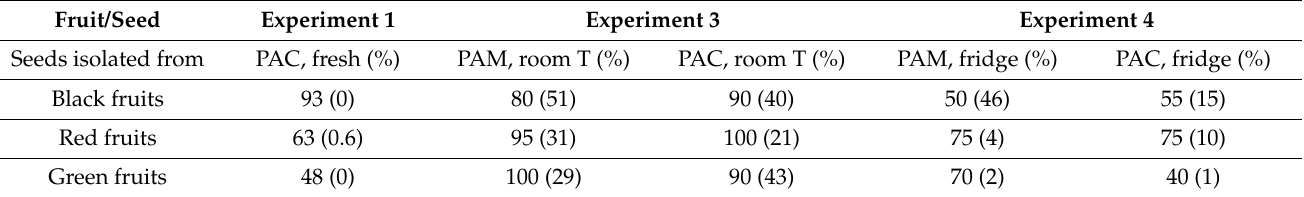
Table 1. The results of the tetrazolium test of ungerminated seeds from experiments 1, 3, and 4. The numbers represent the percentage of potentially viable seeds, and the numbers in brackets are the percentages of germinated seeds.